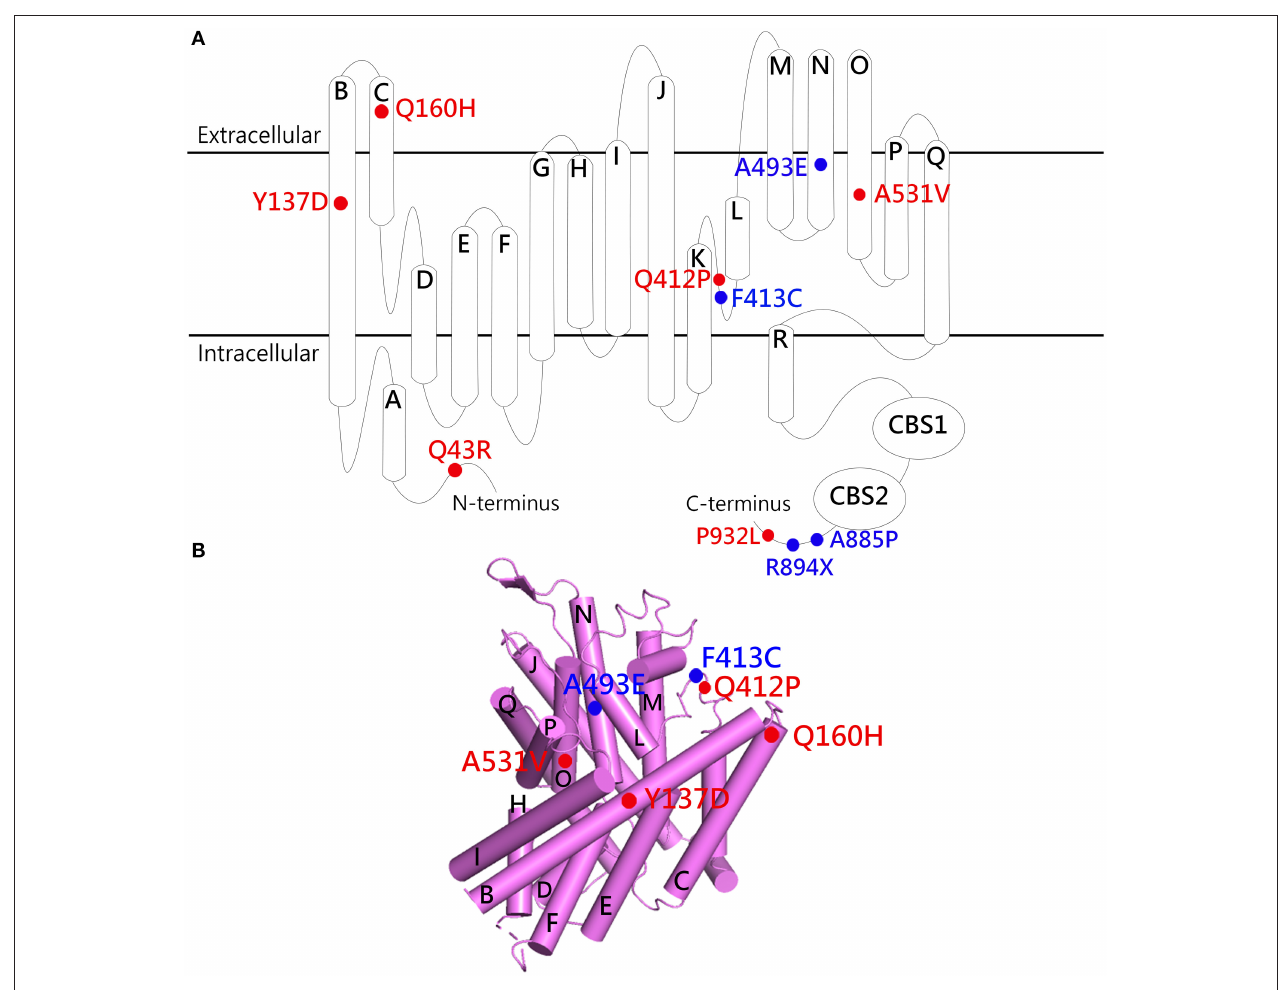
FIGURE 3 | Structural localization of myotonia congenita-associated ClC-1 mutations with defective proteostasis. (A) Membrane topology of the ClC-1 subunit. (B) Lateral view of the transmembrane portion of the human ClC-1 cryo-EM structure (PDB code: 6QVC; presented using Pymol). The α -helices are shown as cylinders. Red labels, mutants with gating properties similar to those of WT; blue labels, mutants with altered gating properties. See Table 1 for more